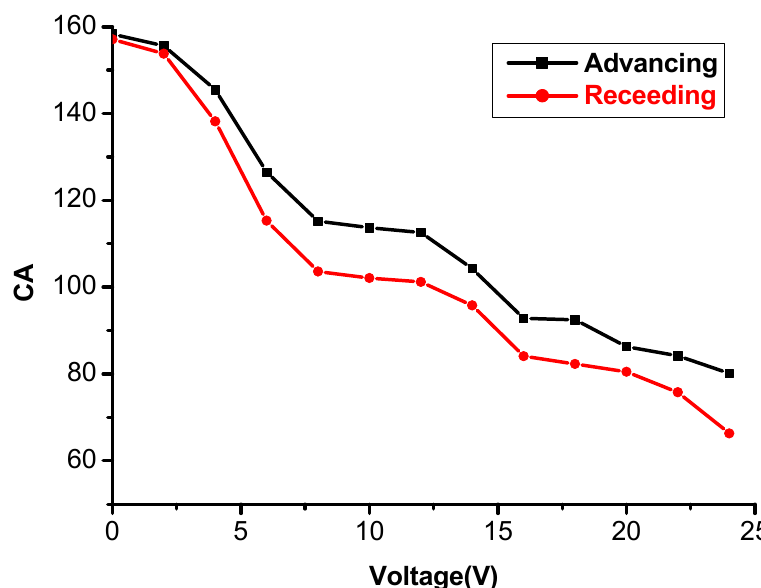
Figure 8. The advancing and receding angles of the porous film prepared from the solution of 0.8% at different